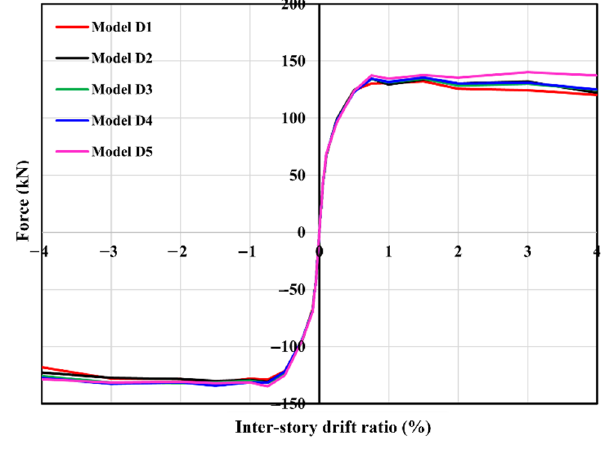
Figure 26. Lateral strength versus drift ratio curves for reinforcement distribution models.